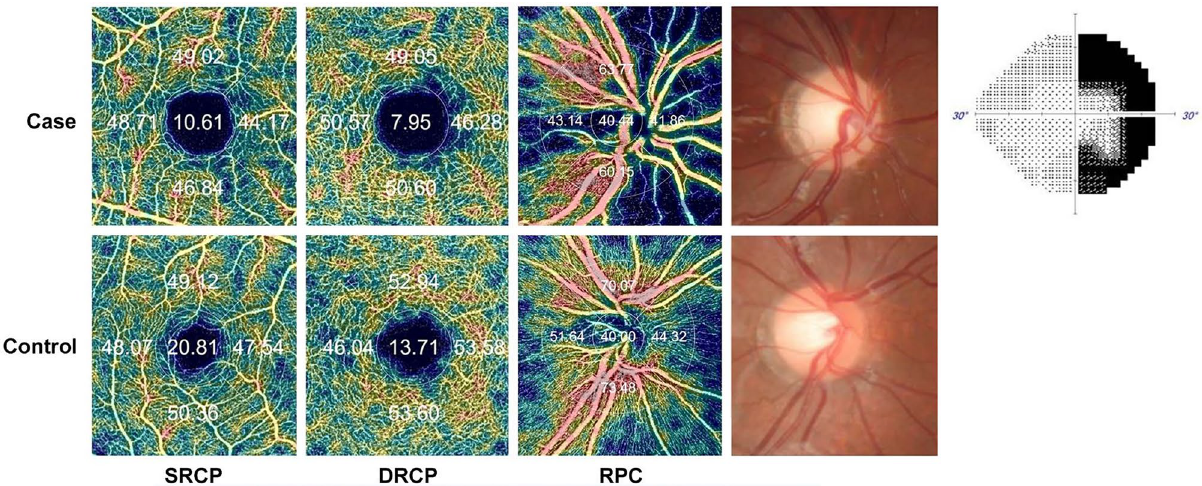
Figure 1. Typical parafoveal and peripapillary en-face images of eyes with pediatric and juvenile craniopharyngioma and a control eye by optical coherence tomography angiography. Color-coded flow maps reveal the automated measurement of vessel density (percentage) by auto-segmentation including the superficial retinal capillary plexus (SRCP), deep retinal capillary plexus (DRCP), and the radial peripapillary capillary (RPC) segment. The parafoveal and peripapillary vessel densities of eye with CP are lower and temporal visual field sensitivity loss is